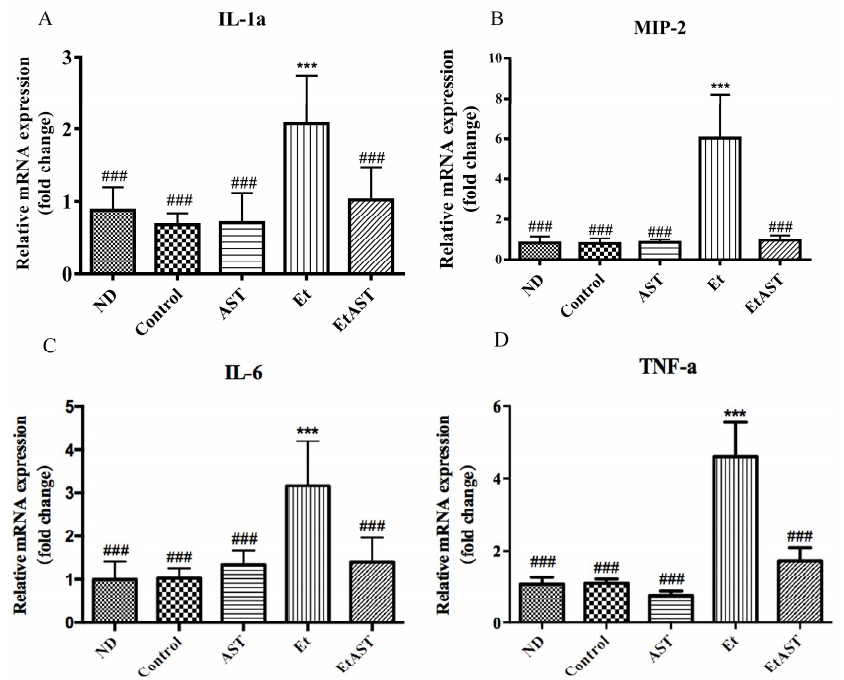
Figure 2. Effect of astaxanthin on inflammatory genes expression in alcoholic fatty liver disease (AFLD) mice. At the end of the experiment, total RNA was extracted from liver tissues. The mRNA expressions of interleukin-1 alpha (IL-1α) ( A ), macrophage inflammatory protein 2 (MIP-2) ( B ), interleukin-6 (IL-6) ( C ), and tumor necrosis factor-alpha (TNF-α) ( D ) were normalized to that of β-actin. Data are presented as means ± SD, n = 6. *** p < 0.001 compared with the control (Con) group, and ### p < 0.001 compared with the Et group.